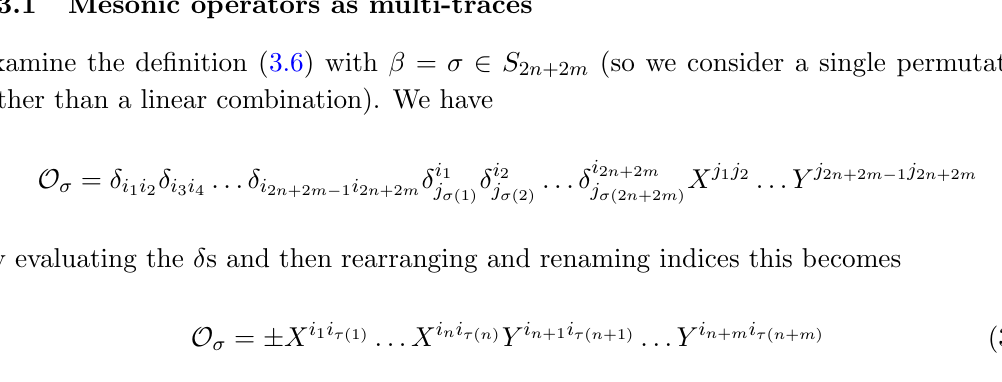
Figure 3 . A diagrammatic representation of the index contraction in a baryonic operator. The " vertex has N legs and there are n X s, m Y s and q diagram shows N = 2 n , but in general this does not have to be the